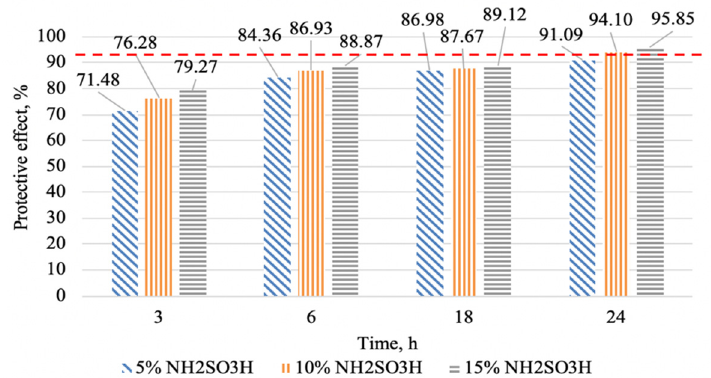
Figure 6. Dependence of the protective effect of the inhibitor in aqueous solutions of NH 2 SO 3 H on time, conc. IC-2 0.4% wt., t = 20 °C.